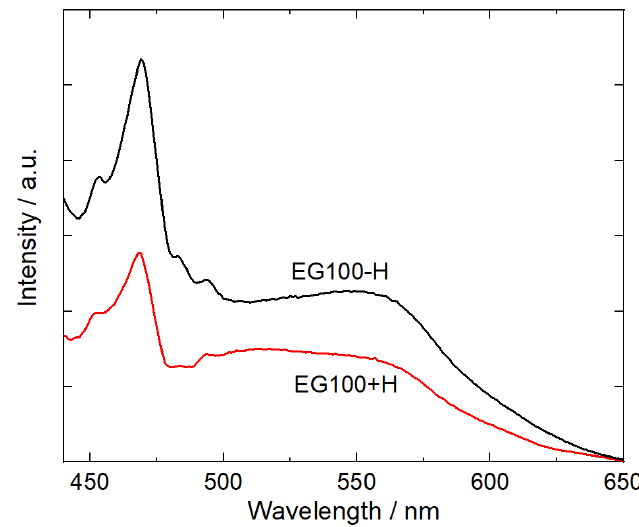
Figure 9. Photoluminescence spectra of EG100-H and EG100+H samples.